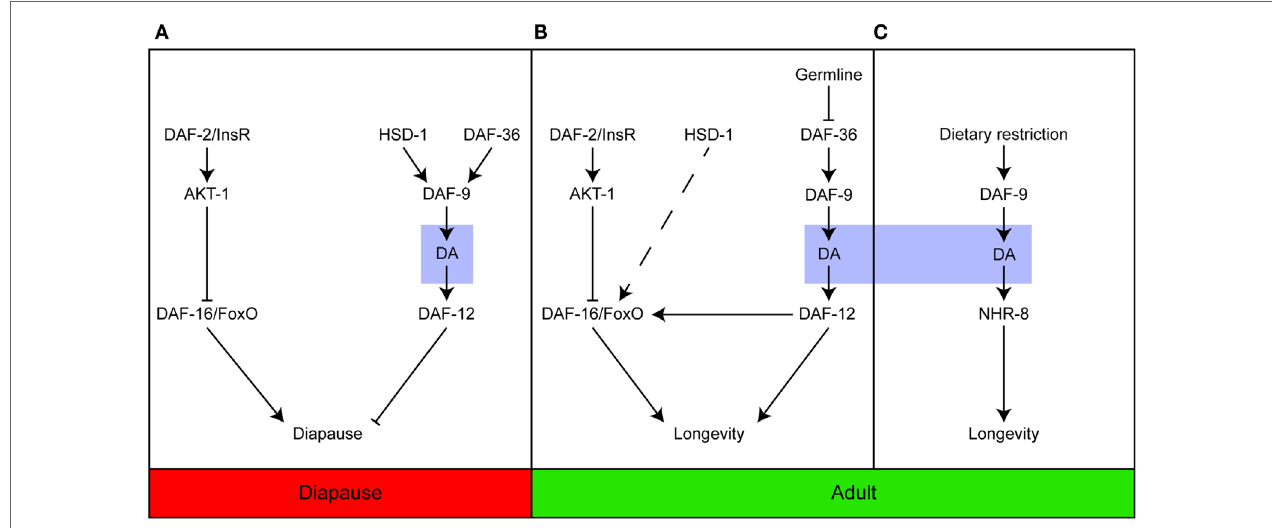
FiGURe 1 | Dafachronic acid plays important roles in developing and adult worms . Steroid signaling is important for entry into the Dauer diapause (A) ; longevity in response to germline ablation (B) ; and the response to dietary restriction (C) . In contrast to (A,B) , which are dependent on the activation of DAF-12, dietary restriction induces longevity via NHR-8. Adapted from Dumas et al.